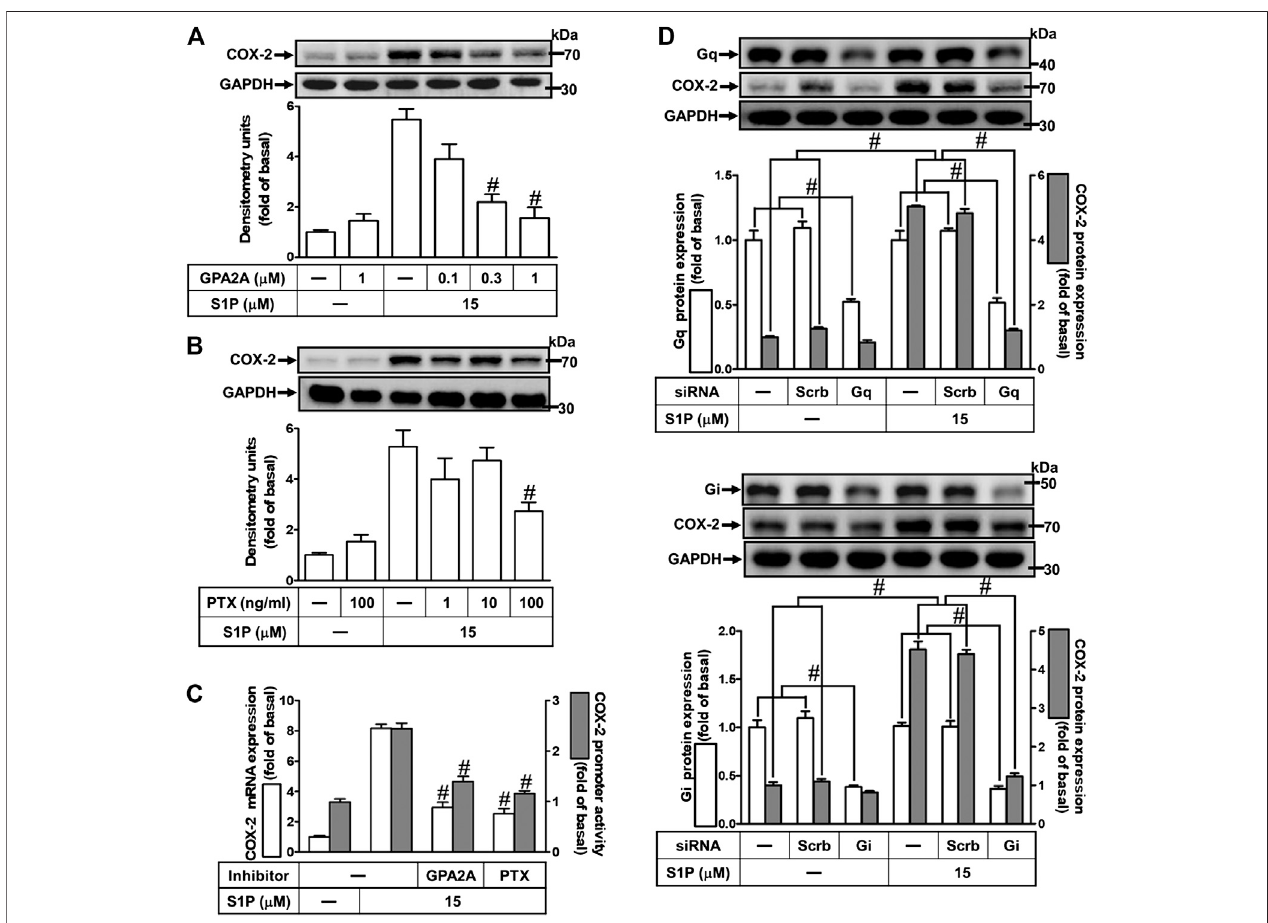
FIGURE3| S1PinducesCOX-2expressionviaaG q -orPTX-sensitiveG i protein-coupledS1PR1/3. (A,B) CellswerepretreatedwithGPA2A(G q antagonist)for1 h or pertussis toxin (PTX, G i protein inactivator) for 24 h and then incubated with 15 μ M S1P for 8 h. (C) Cells were transfected without or with COX-2 promoter-luciferase reporter gene, pretreated with GPA2A (1 μ M) or PTX (100 ng/ml) for 1 h, and then incubated with 15 μ M S1P for 4 h (mRNA) or 1 h (promoter). The COX-2 mRNA and promoter activity were analyzed by real time-PCR (open bar) and promoter assay (gray bar). (D) Cells were transfected with siRNA for scrambled, G q α , or G i α